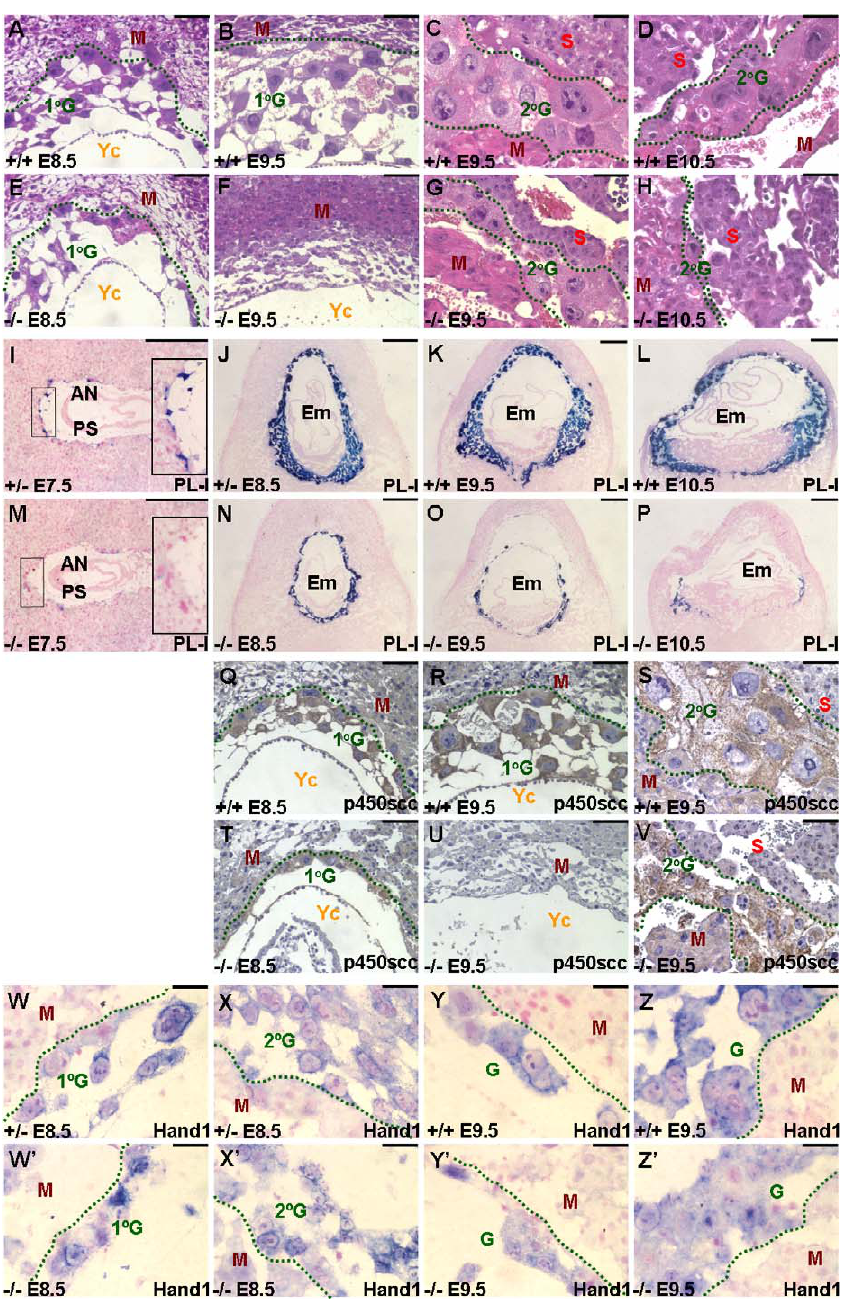
Figure 4. Development of TGCs is Impaired in the SENP2 Mutants (A–H) Histological analysis of the SENP2 þ / þ (A–D) and SENP2 –/– (E–H) placentas revealed impaired development of both primary (1 8 G; A,B,E,F) and secondary (2 8 G; C,D,G,H) caused by SENP2 ablation at E8.5 (A,E), E9.5 (B,C,F,G) and E10.5 (D,H). (I–P,W–Z 9 ) TGC development was examined by in situ hybridization analysis of specific markers PL-I (I–P) and Hand1 (W–Z and W 9 –Z 9 ) at the stages shown (E7.5–E10.5). Stained (blue) sections were counterstained with nuclear fast red. In (I, M), enlargements of the left insets are shown on the right insets. (Q–V) Immunostaining of p450scc characterized the TGC in SENP2 þ / þ (Q–S) and SENP2 –/– (T–V) at E8.5 (Q,T), and E9.5 (R,S,U,V). Immunostained (brown) sections were counterstained (blue) with hematoxylin. The TGC layers are defined by broken green lines (A–E,G,H,Q–Z,W 9 –Z 9 ). AN, anterior neural fold; Em, embryo; G, TGC layer; M, maternal decidua; PS, primitive streak; S, spongiotrophoblast layer; Yc, yolk sac cavity. Scale bars, 500 l m (I–P); 100 l m (A,B,E,F,Q,R,T,U); 50 l m (C,D,G,H,S,V,W–Z,W 9 –Z 9